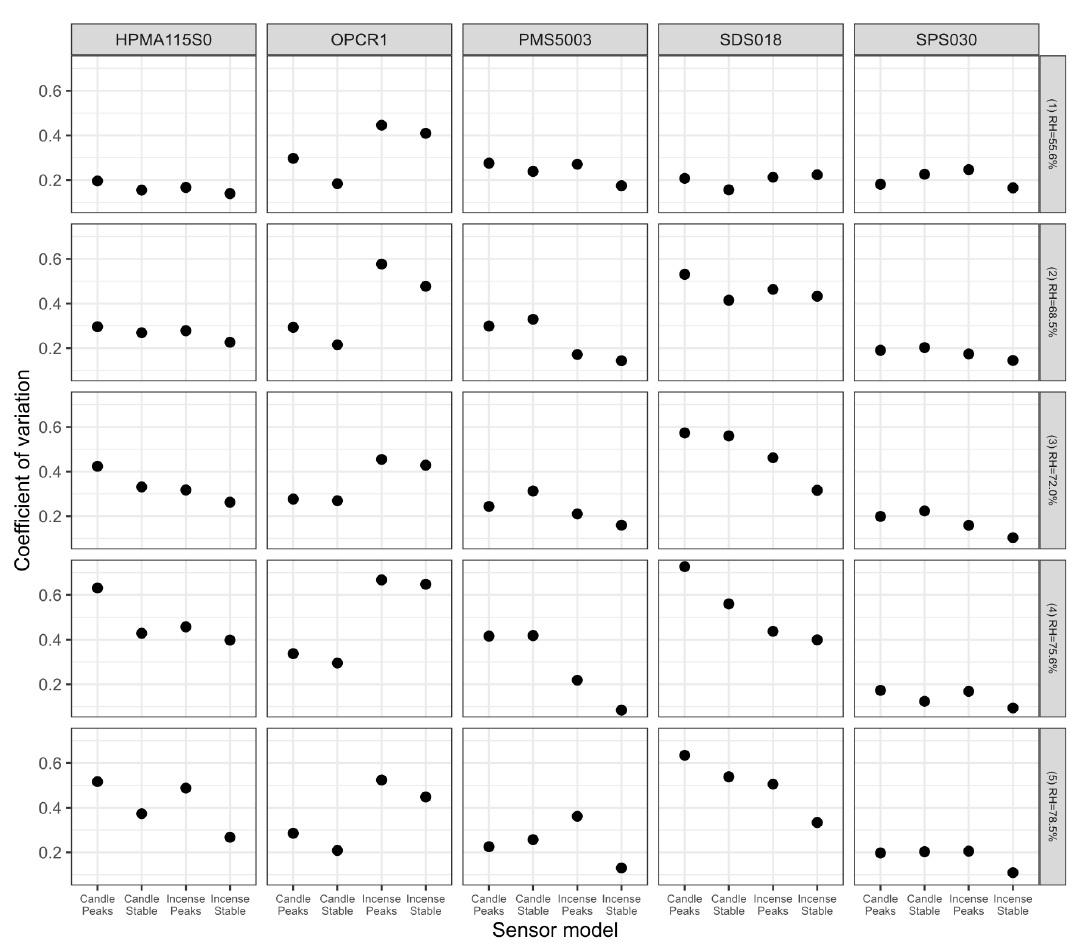
Figure A15. Coefficient of variation obtained by the different models of sensors for the different experiment, the different sources and different variations of PM